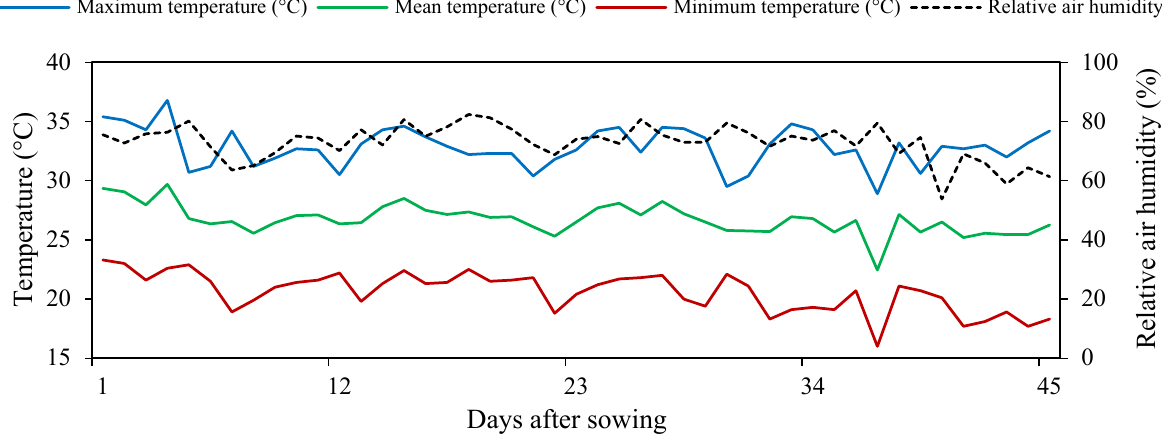
Figure 1. Daily maximum, mean, and minimum temperatures and average relative air humidity observed in the internal area of the greenhouse during the experimental period.